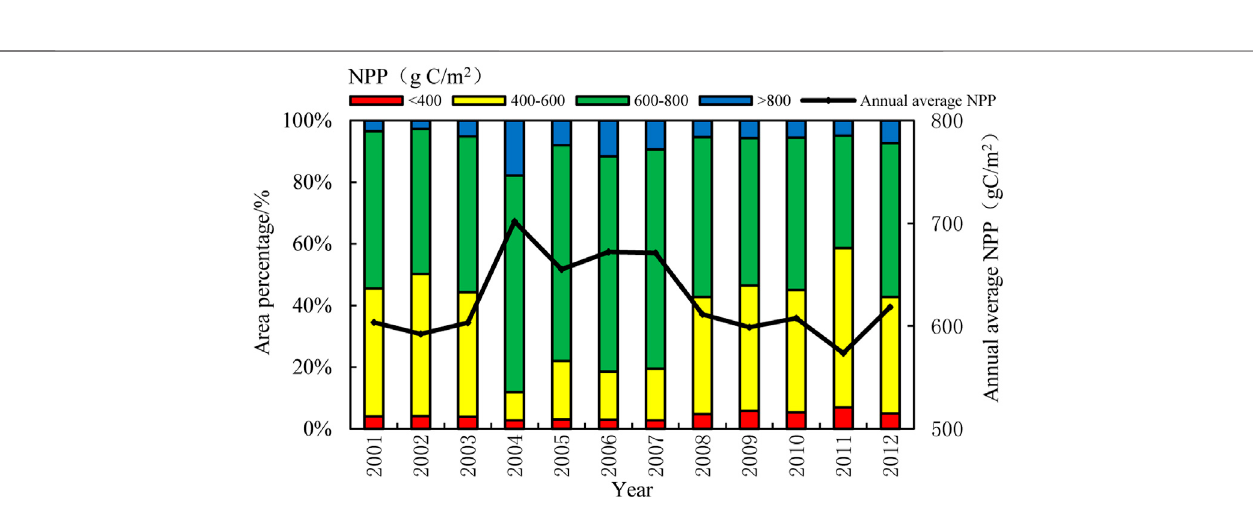
FIGURE 5 | Temporal variations of the annual average NPP.